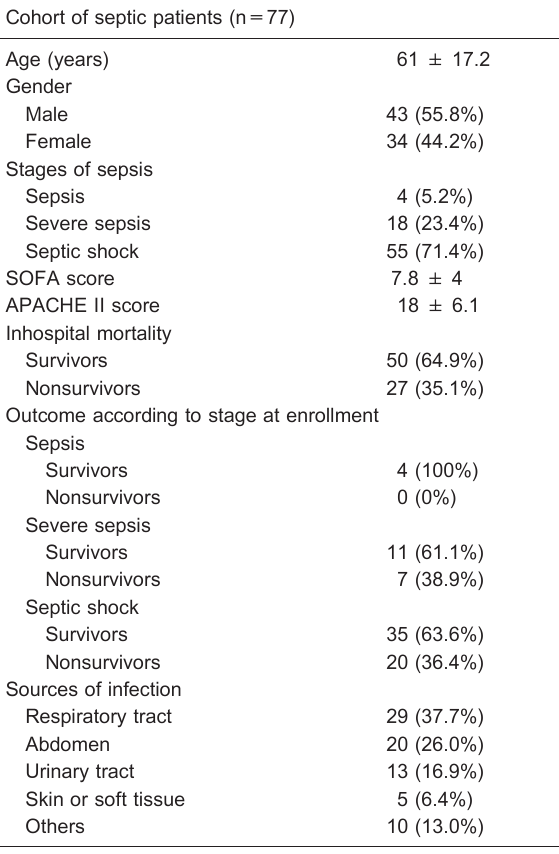
Table 1. Demographic data and outcomes from septic patients included in the